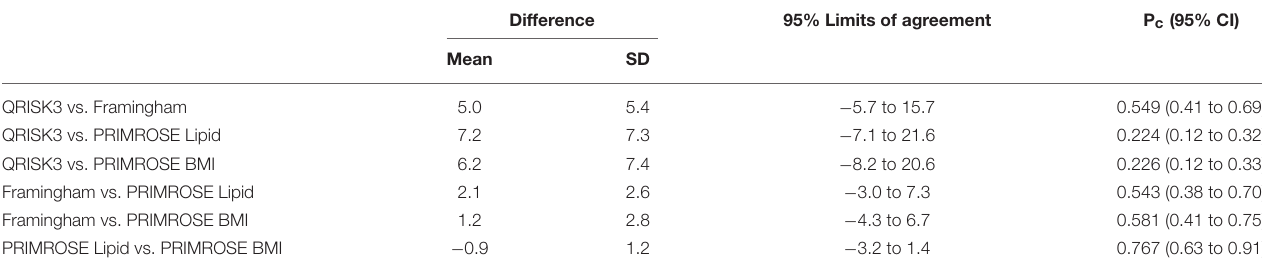
TABLE 4 | Agreement among 10-year predicted CVD risk models (%).